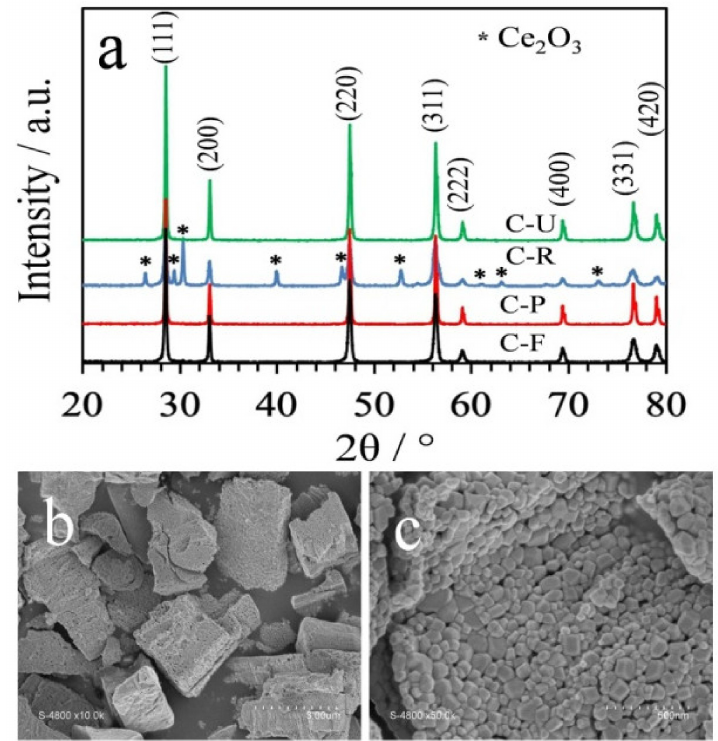
Figure 1. Characterization of ceria materials used in this study: ( a ) Powder X-ray diffraction (XRD) patterns of as-received fresh CeO 2 oxygen carriers (C-F), ceria after pre-treatment (C-P), ceria after reduction (C-R), and ceria used after one complete cycle (C-U), (*) denotes Ce 2 O 3 phase; ( b , c ) SEM images of fresh CeO 2 oxygen